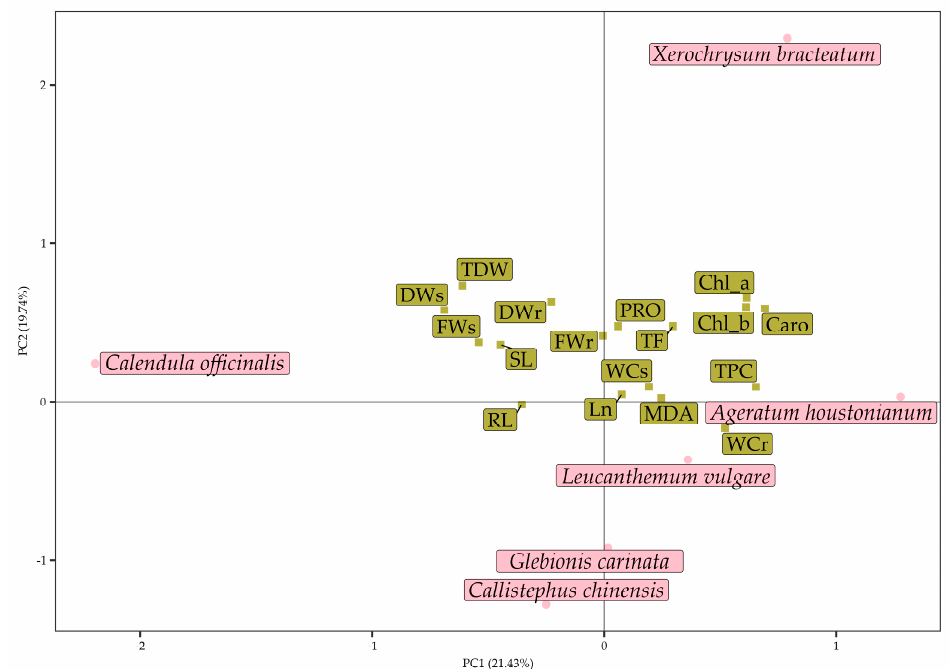
Figure 6. PCAcon biplot. Pink circles indicate the barycentres of the six studied species, whereas the green squares represent the 17 measured traits under control conditions (i.e., no drought stress).